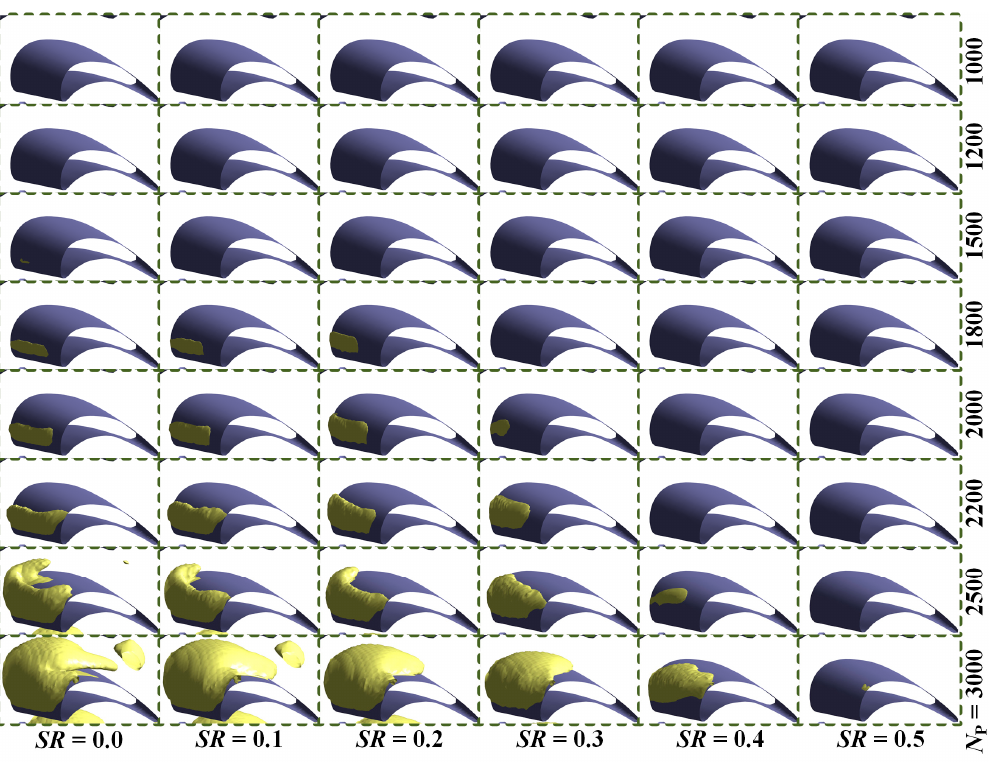
Figure 13. The 10% vapor volume fraction distribution in stator domain under various N P and SR.